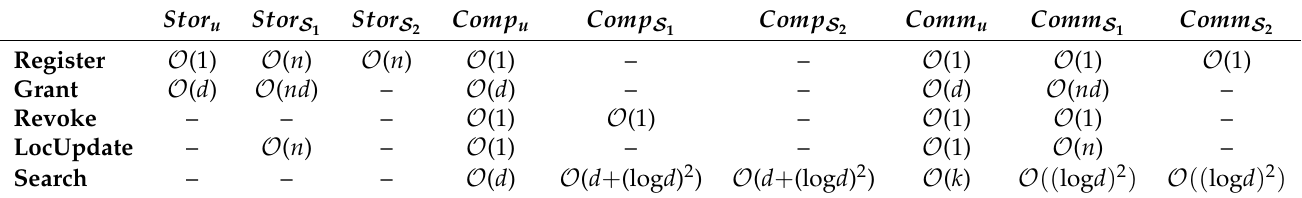
Table 1. Complexity analysis.